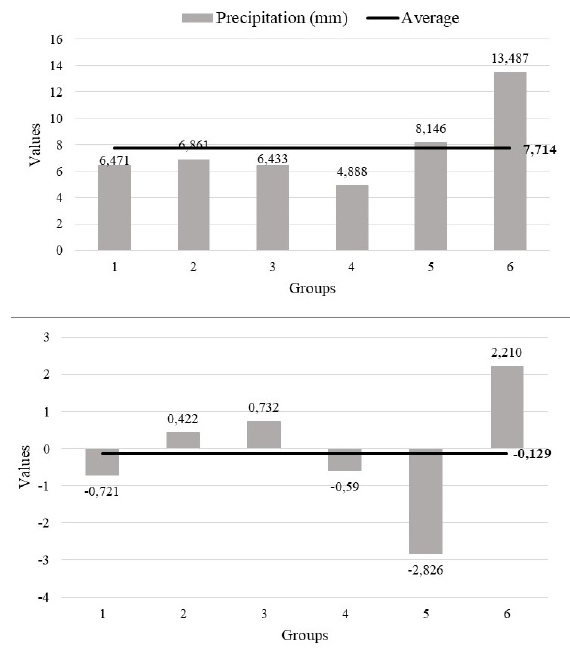
Figure 3. RMSE (a) and MB (b) values for the study area - minimum temperature (°C).